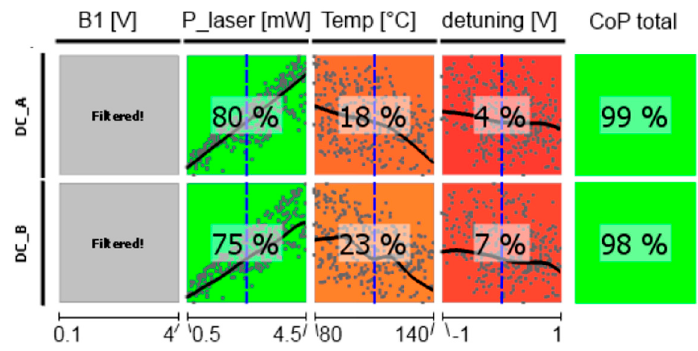
Figure 11. CoP matrix of the dc photocurrents of the medium-pressure magnetometer. Approximation technique: moving least squares (DC_A) and isotropic kriging (DC_B).